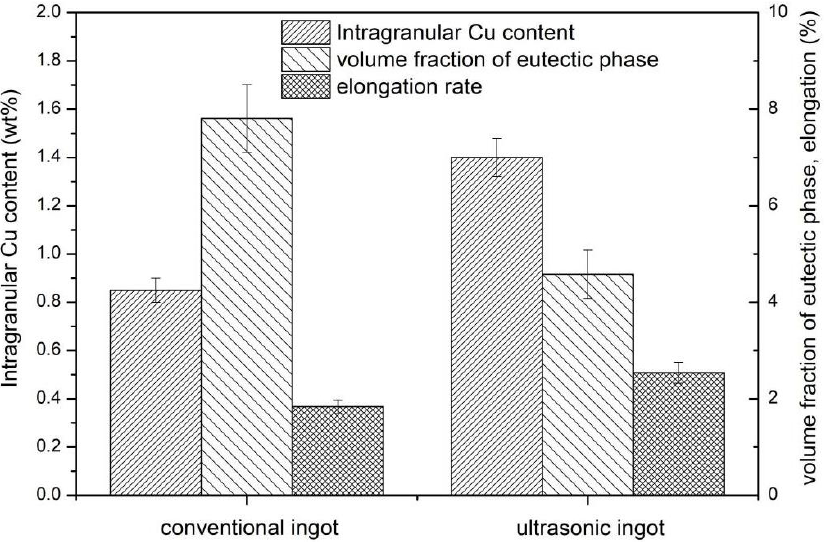
Figure 8. Relationship of intragranular Cu content, volume fraction of eutectic phase, and elongation rate of conventional ingot and ultrasonic